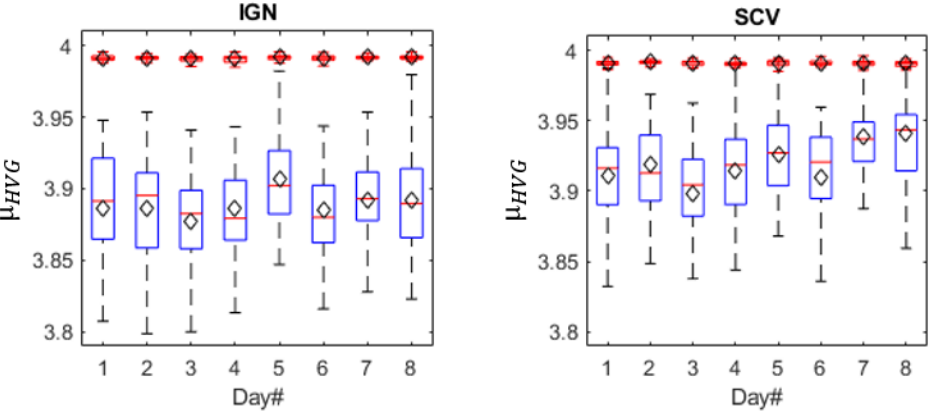
Figure 14. µ 𝐻𝑉𝐺 values computed for spark and noise data at sensor locations IGN and SCV. Figure 14. µ HVG values computed for spark and noise data at sensor locations IGN and